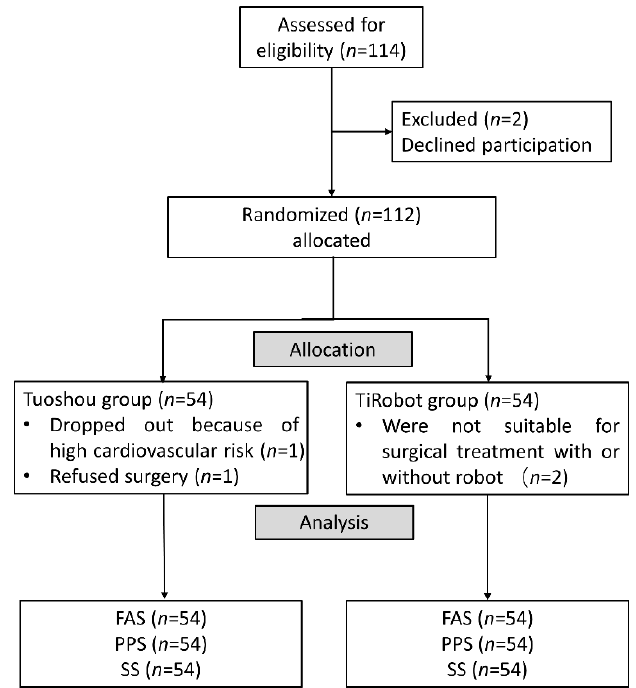
Figure 4. Flow chart of included Figure 4 . Flow chart of included patients.